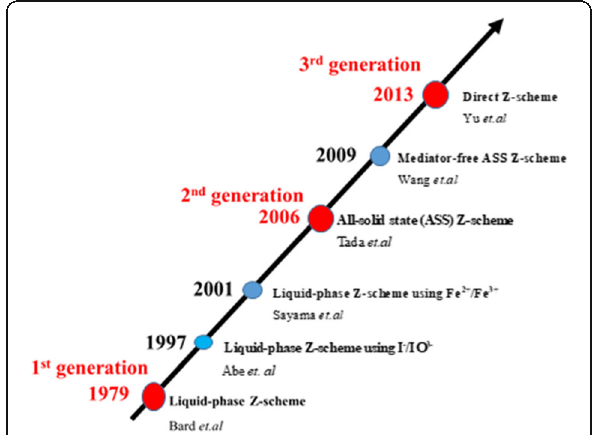
Fig. 3 The roadmap of the evolution of z-scheme photocatalytic system. Reproduced with permission from [3] with slight modifications. Copyright 2017 WILEY-VCH Verlag GmbH &